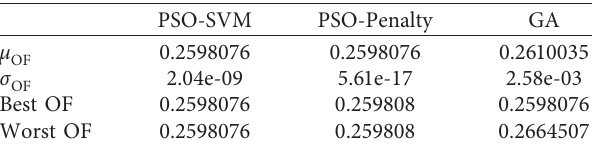
Figure 6: Structural example 1: simply supported beam, case piecewise linear decreasing relax function. (a) 3D graph of simply supported beam problem design space. (b) Generation 1. (c) Generation 2. (d) Generation 50. (e) Generation 100. (f) Objective function history. Table 4: Structural Example 1: results from PSO-SVM piecewise linear decreasing relax constraints, PSO-Penalty, and